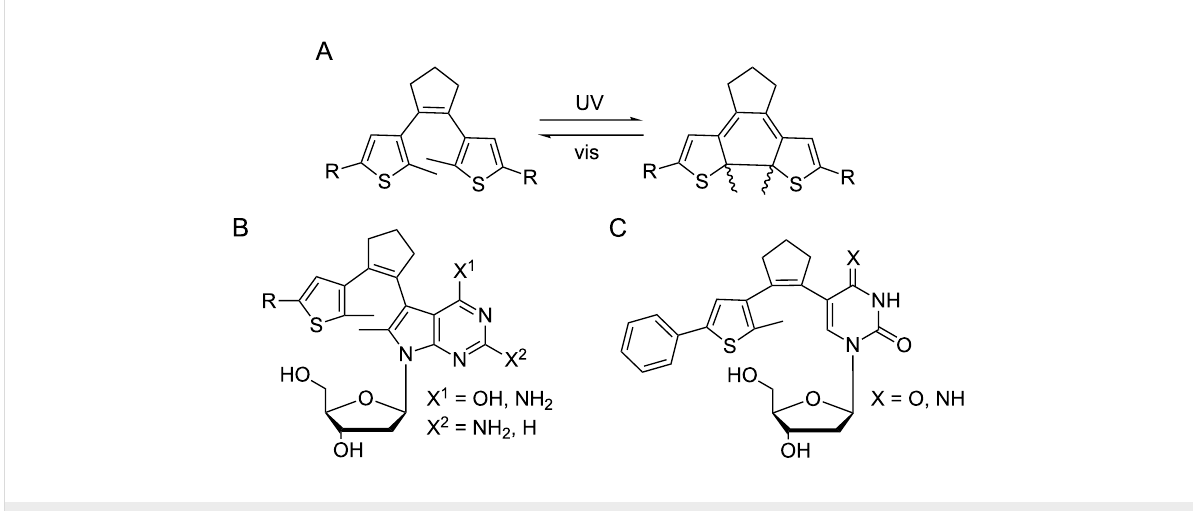
Figure 1: Diarylethene photoswitches. A: classical design and photoisomerization reaction [27]. B: purine-based photoswitches (1 st generation) [43,44], C: pyrimidine-based photoswitches (2 nd generation) [45].